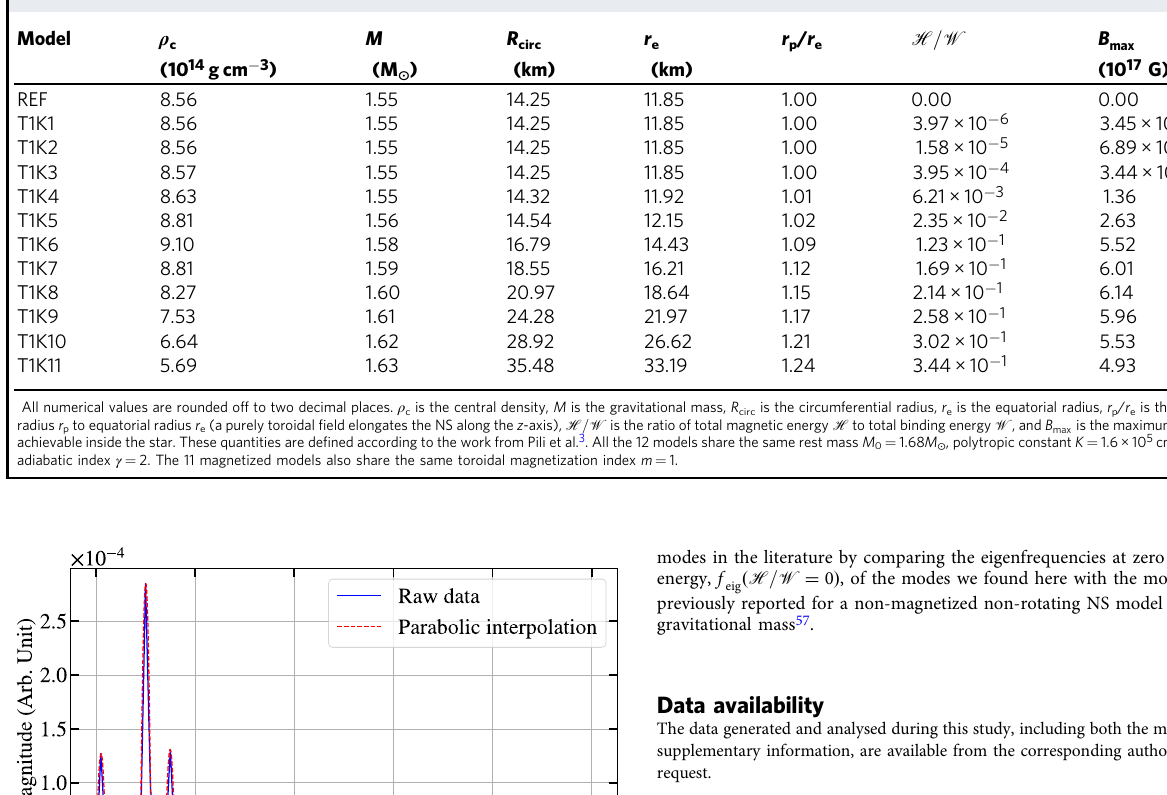
Table 2 Stellar properties of the 12 equilibrium models constructed by the XNS code.